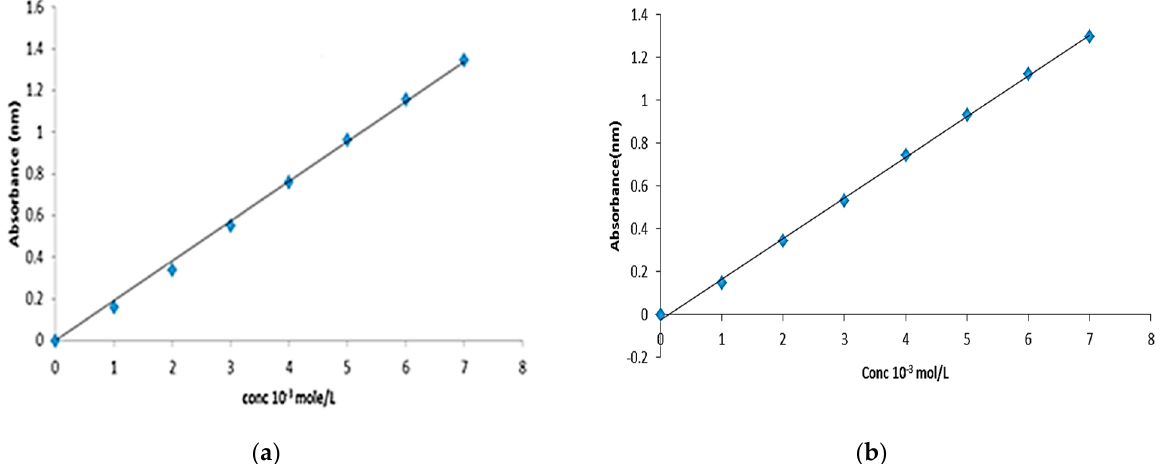
Figure 3. Calibration curves for ( a ) acid red 4 ( b ) methylene blue.